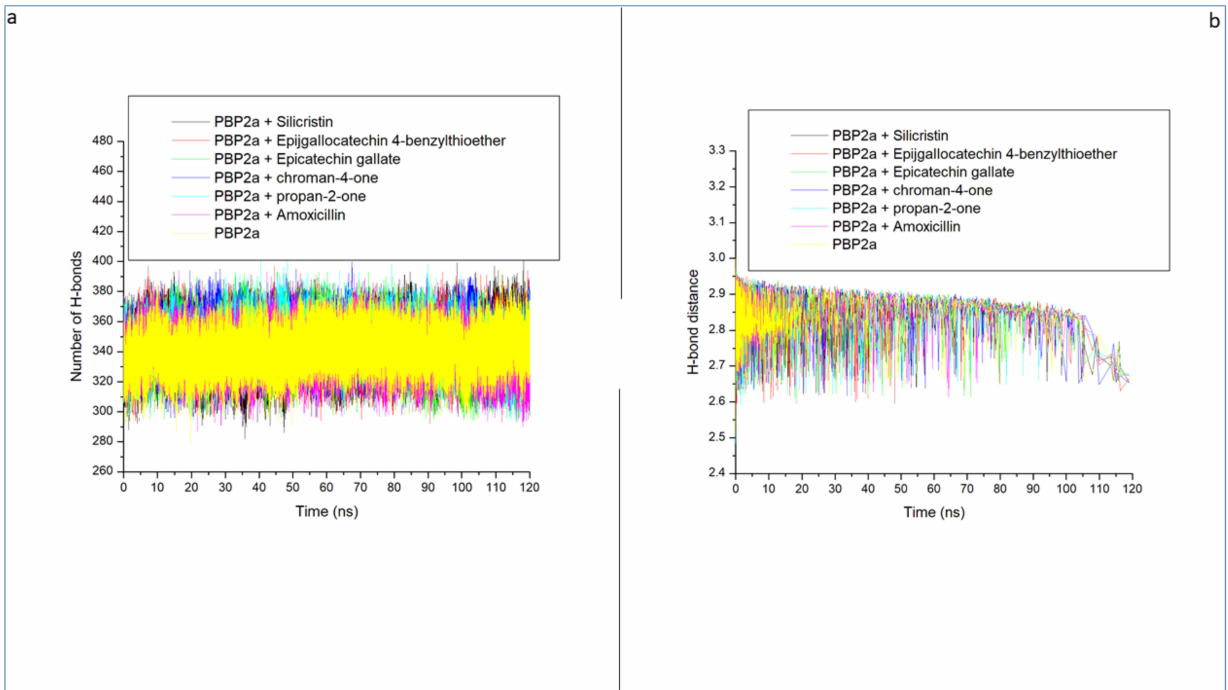
Figure 8. Time evolution of the number of intramolecular hydrogen bonds ( a ) and distance ( b ) formed in PBP2a following the binding of amoxicillin and the top-five phenolics at the active site of PBP2a of S. aureus during the 120 ns MD simulation